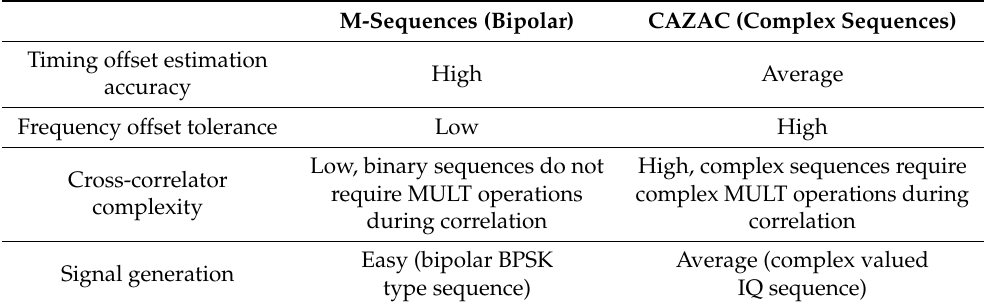
Table 2. Design Tradeoffs for Different Preamble Types.